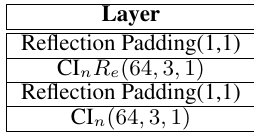
Figure 2. Train, Validation and Test configuration.